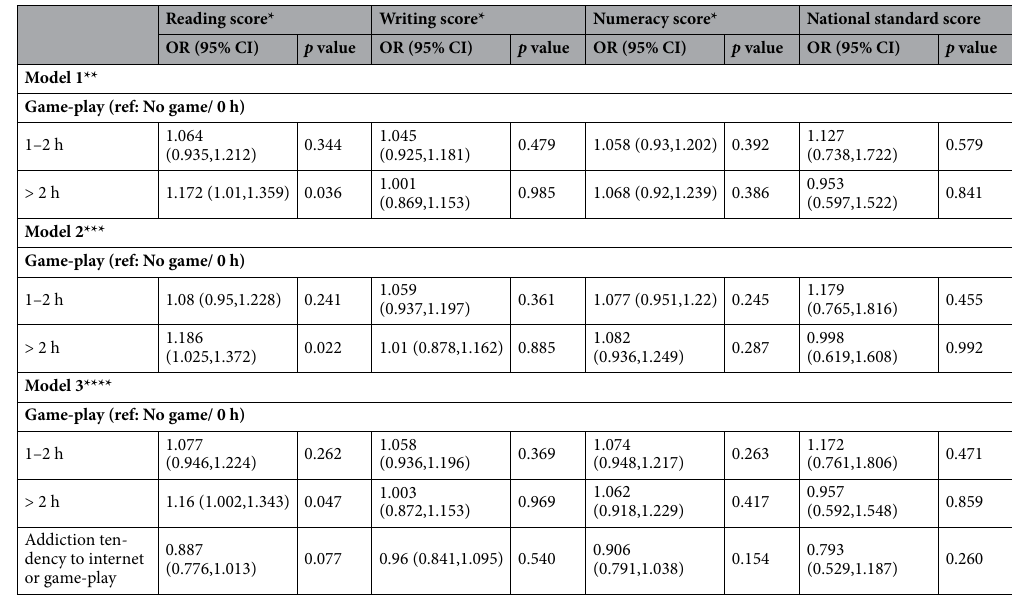
Table 6. Generalized linear model fitted to various scores and national standard scores for weekends game- play adjusting the behavioural and sociodemographic factors, as well as survey weights. *Standardized (mean of 0 and a standard deviation of 1). **The model was adjusted for age and sex of the child, household income, primary carer’s education and family type. ***Model 2 was adjusted for age and sex of the child,